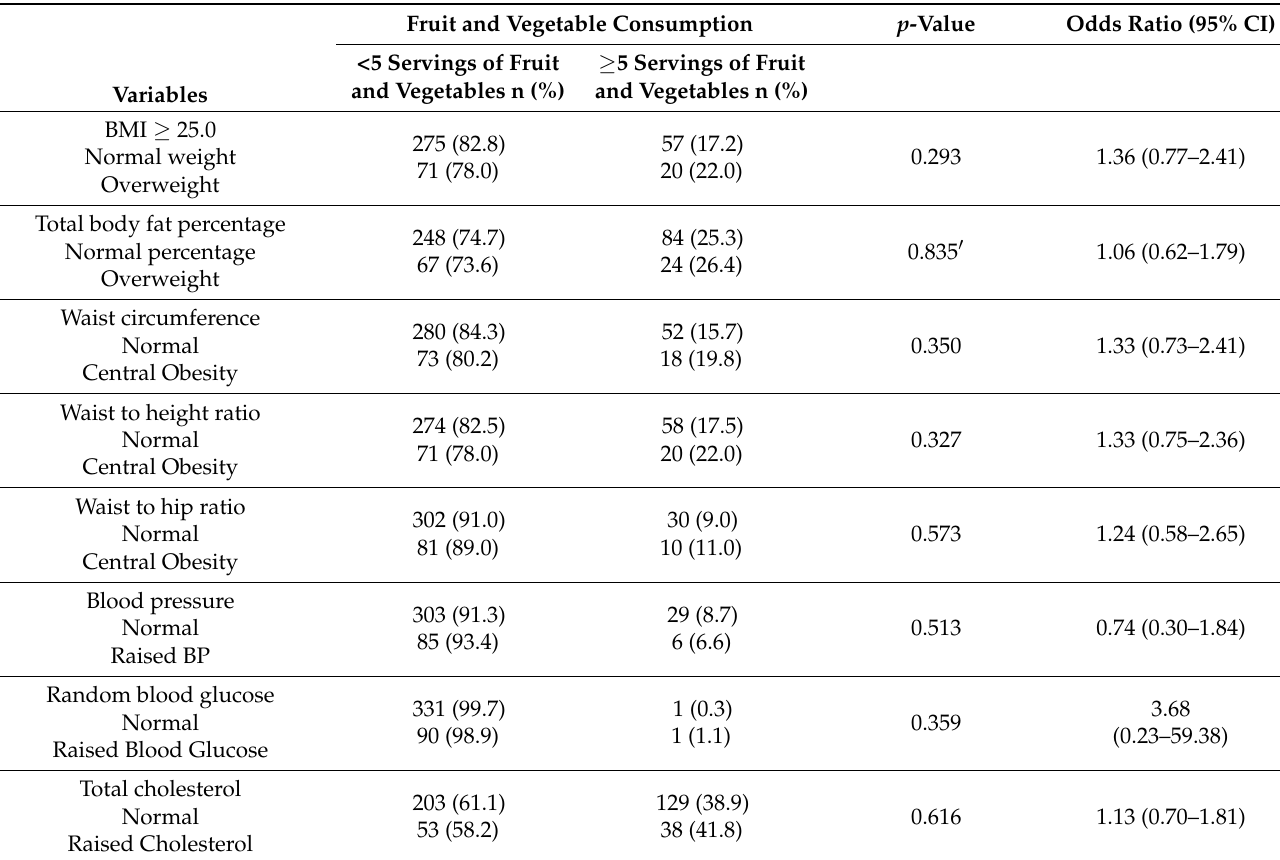
Table 5. Association of fruit and vegetable consumption with biological risk